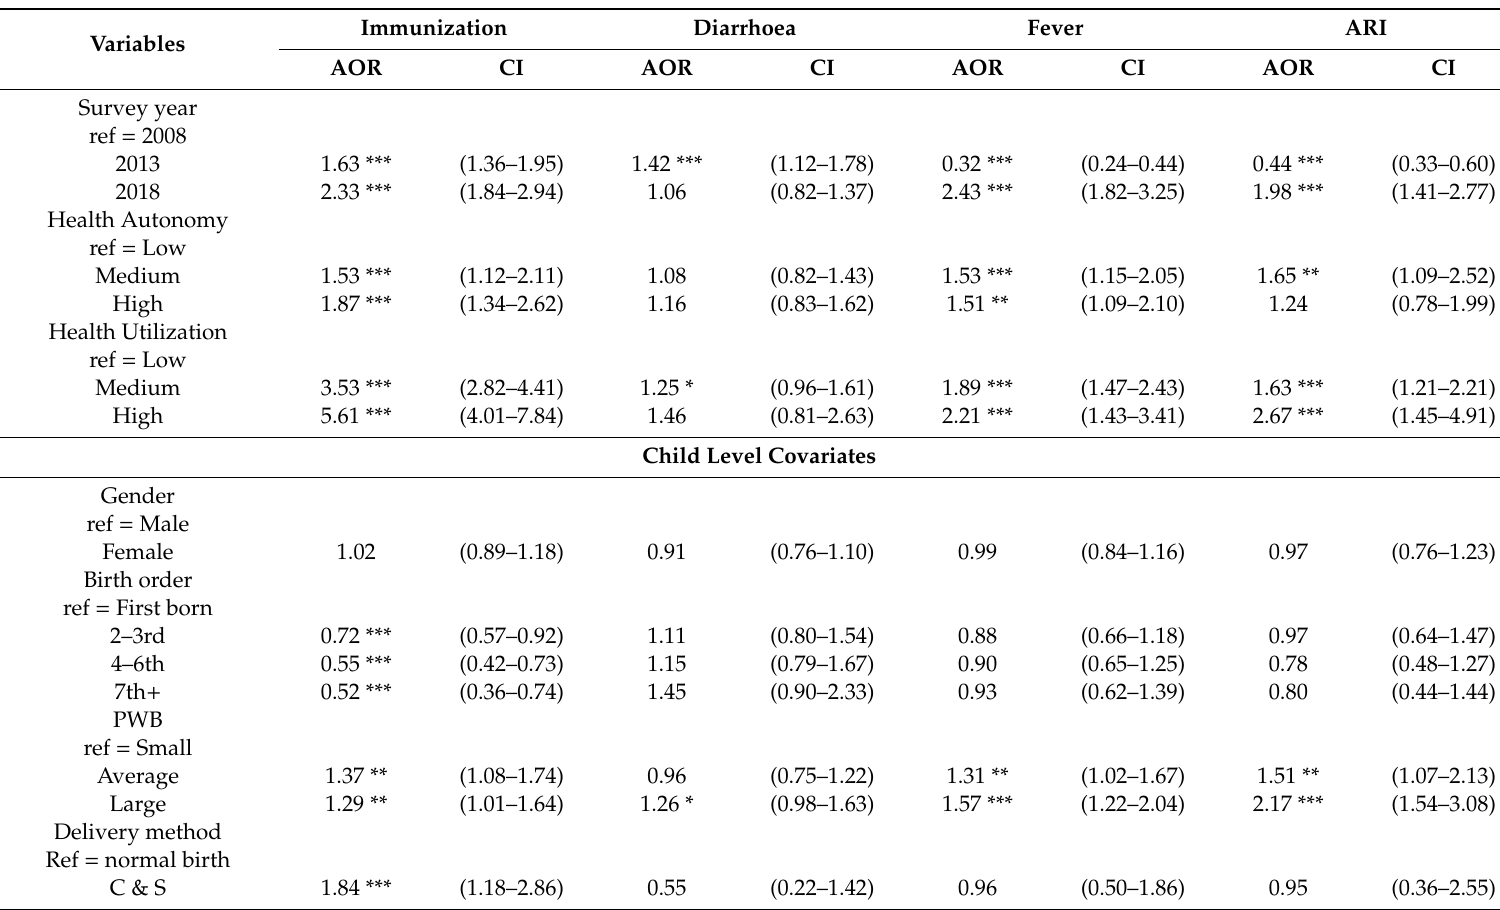
Table 4. Adjusted Odds Ratio from Multilevel Logistic Regression on Preventive and Curative Child Healthcare in Nigeria